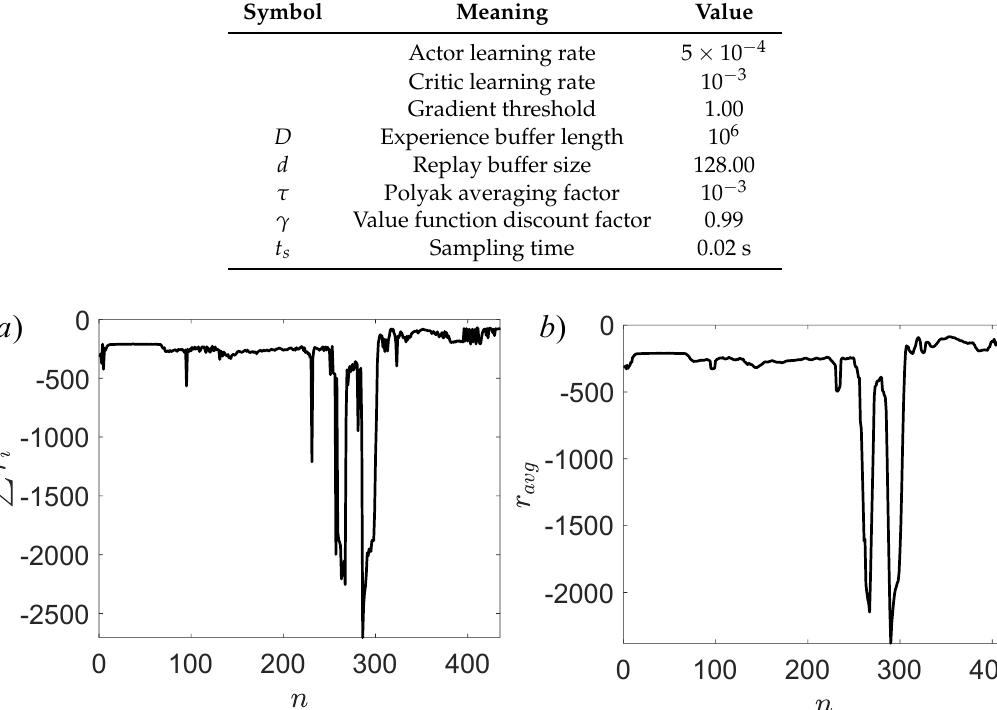
Figure 5. Learning curves of the agent. ( a ) Cumulative reward per episode of training. ( b ) Average cumulative reward in a moving window including five